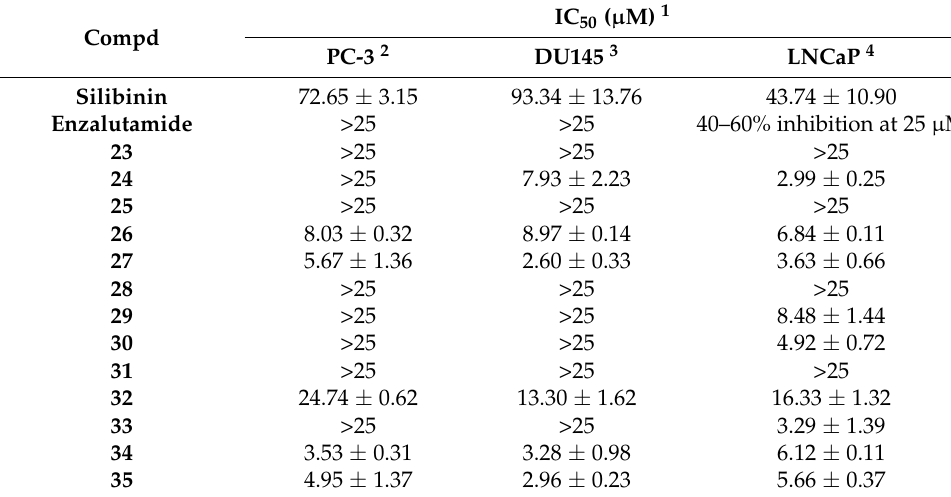
Table 3. Antiproliferative activity of chalcone-type flavonolignans.